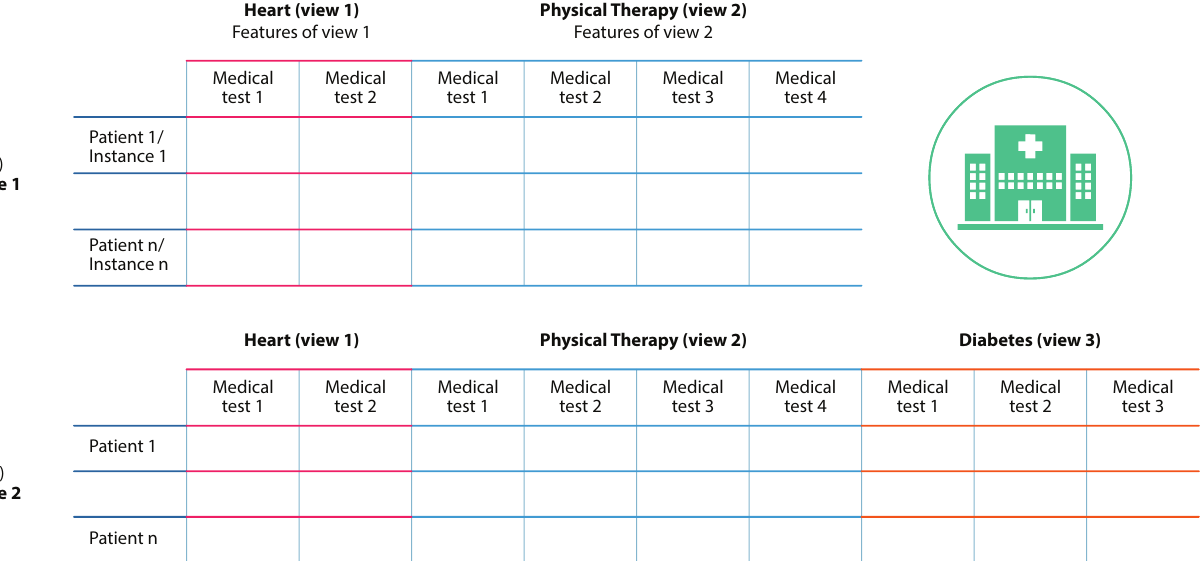
Figure 1. Healthcare application that ( a ) demonstrates two clinics, namely heart and physical therapy, with their own features and ( b ) demonstrates a new healthcare clinic, namely diabetes, which has an additional group of features (i.e.,